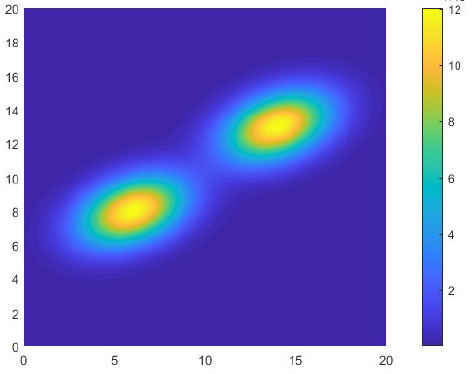
Figure 4. Initial target probability map.